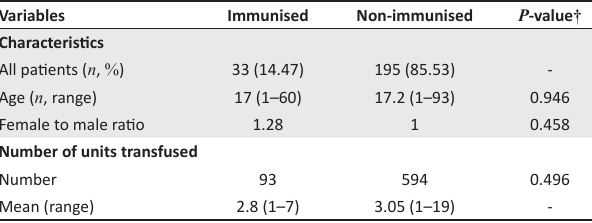
TABLE 3: Characteristics of immunised and non-immunised transfused sickle cell and cancer patients at Kenyatta National Hospital, 2014.